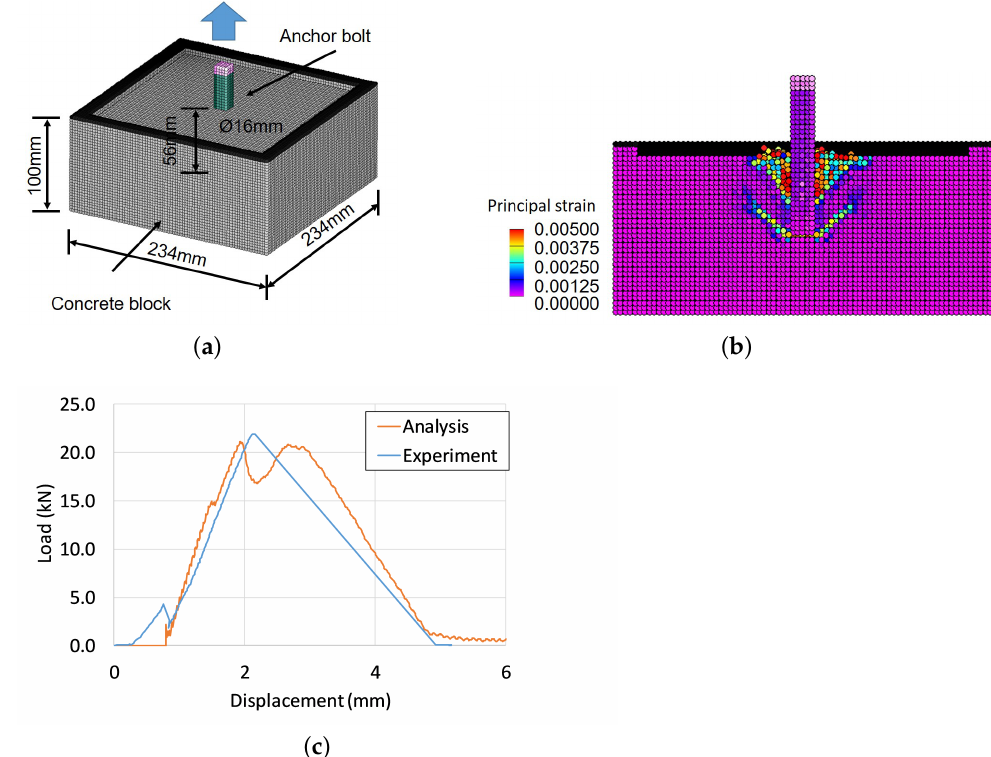
Figure 10. SPH analysis for the pull-out process in experiment [6]. ( a ) Analysis model. ( b ) Complex fracture pattern by numerical analysis. ( c ) Comparison of load-displacement